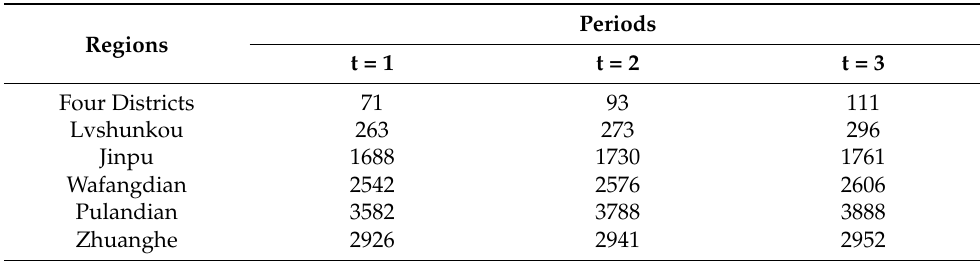
Table 6. The initial optimal allocation of water resources for ecological environment sector in Dalian (10 4 m 3 /year).